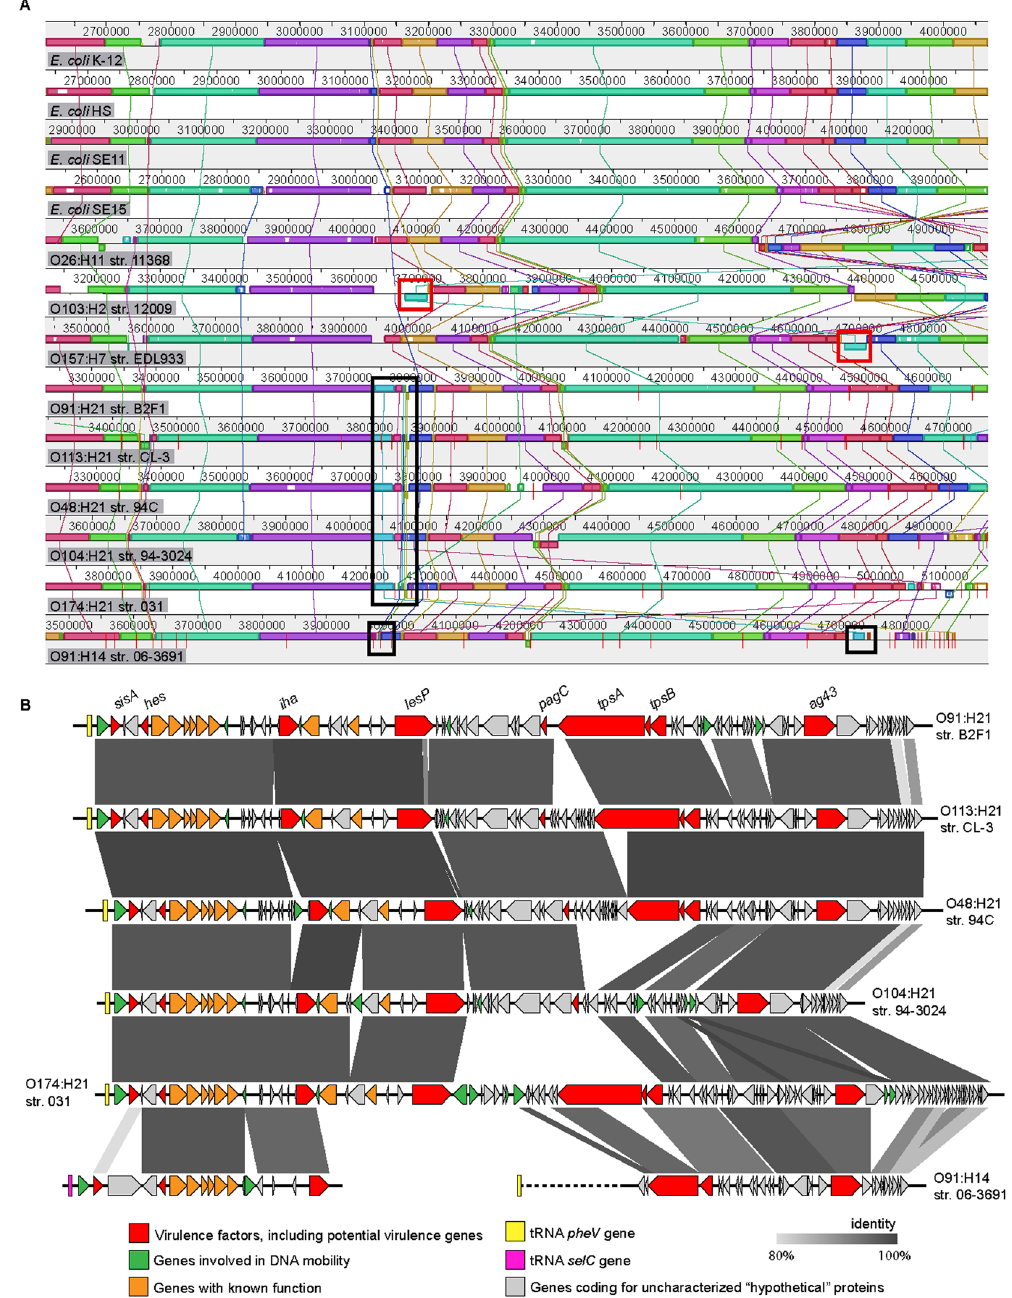
Figure 3. Identification of the LAA pathogenicity island in LEE-negative STEC strains. ( A ) Alignment between genomes of representative LEE-negative STEC strains (O48:H21, O91:H14, O91:H21, O104:H21, O113:H21 and O174:H21), LEE-positive STEC strains (O26:H21, O103:H2 and O157:H7) and the genomes of E. coli K-12 MG1655 and commensal E. coli strains (HS, SE11 and SE15). Alignment was performed using progressiveMauve 33 . Genome sequences used are listed in Table S5. The complete genome sequence of E. coli K-12 substr. MG1655 was used as the reference sequence. Colored blocks represent collinear and homologous regions. Non-colored areas represent unaligned sequences that may be genome-specific. Inverted regions are identified by boxes below the central line. Regions between consecutive red lines indicate individual contigs. The location of the LAA pathogenicity island is show by black rectangles. The location of the LEE pathogenicity island is shown by red rectangles. ( B ) A comparison of the genetic structure of the LAA pathogenicity island present in six LEE-negative STEC strains. Predicted genes and the direction of transcription are represented as block arrows. Open reading frames (ORFs) are color coded according to gene function, as indicated in the legend at the bottom. Names of virulence genes are show. Conserved regions are shaded in grey and the intensity of the color indicates nucleotide identity levels, from 80 to 100%. The figure was prepared using EasyFig 53